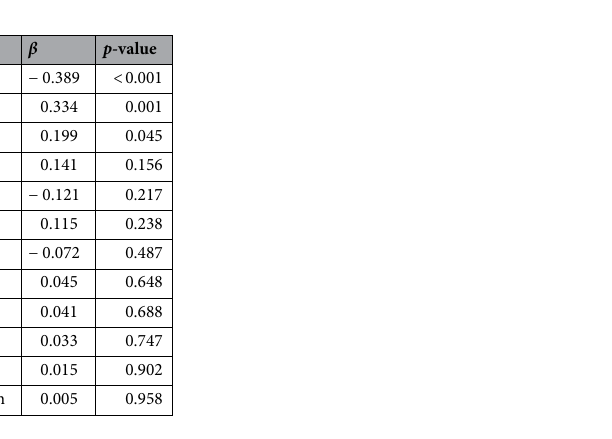
Table 5. Results of multiple regression analysis for independence factors contributing to wall to lumen